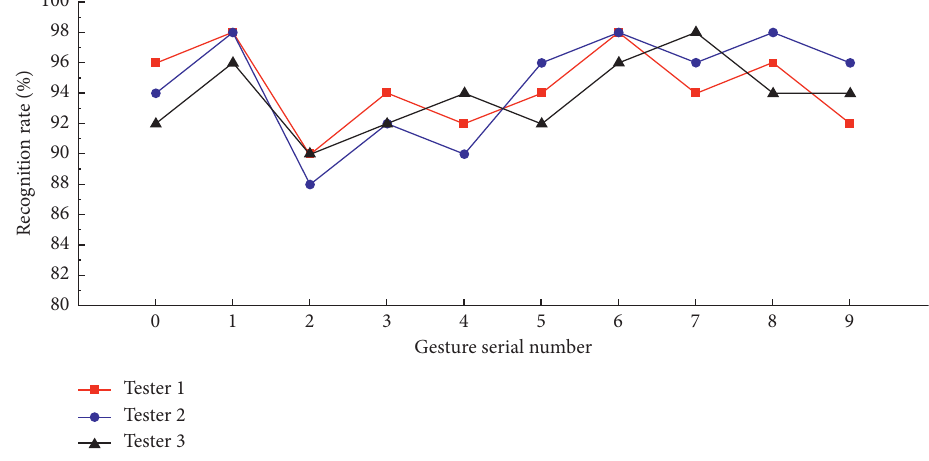
Figure 10: Recognition rate of different